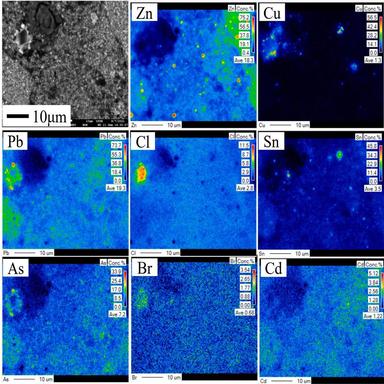
Elemental distribution in SCFD obtained via EPMA.